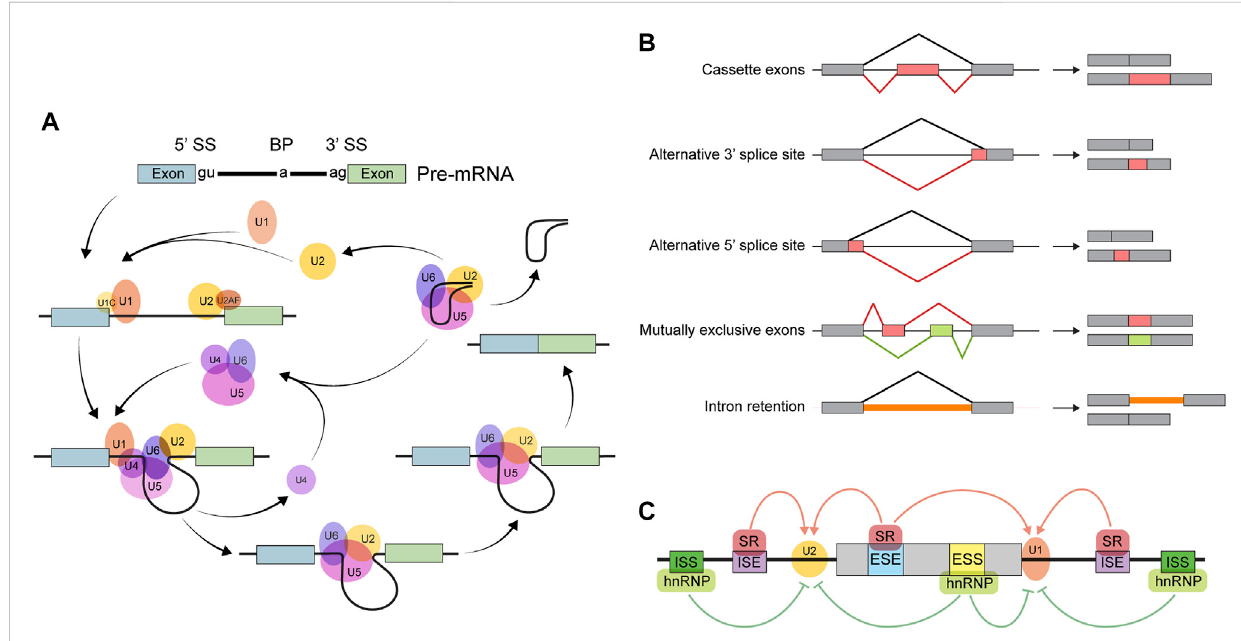
FIGURE 1 Overviewofalternativesplicing. (A) Thesplicingreaction.Thecorespliceosomeconsistsprimarilyof fi vesmallnuclearribonucleoproteins(snRNPs): U1, U2, U4, U5, and U6. The splicing reaction begins when the U1 snRNP binds the 5 ′ splice site (5 ′ SS). Next, U2 and some non-snRNP factors recognize other important sequences, including the 3 ′ splice site (3 ′ SS) and the branch point (BP). The resulting RNA-protein complex then undergoes a series of conformational rearrangements, becoming catalytically active. Finally, in a two-step transesteri fi cation reaction, two exons are ligated and the interveningintronissplicedoutintheformofa ‘ lariat ’ beforebeingsubsequentlydegraded. (B) ThemajortypesofbinaryASevents. (C) Thedeterminants of splicing outcomes. Exonic/intronic splicing enhancer (ESE/ISE) sequences are recognized by splicing activators, such as the serine-rich (SR) family of proteins, which facilitates the action of the splicing machinery. Repressors, such as the heterogeneous nuclear ribonucleoproteins (hnRNPs), bind to exonic/intronic splicing silencers (ESSs/ISSs) to inhibit the components of the spliceosome from recognizing splice site